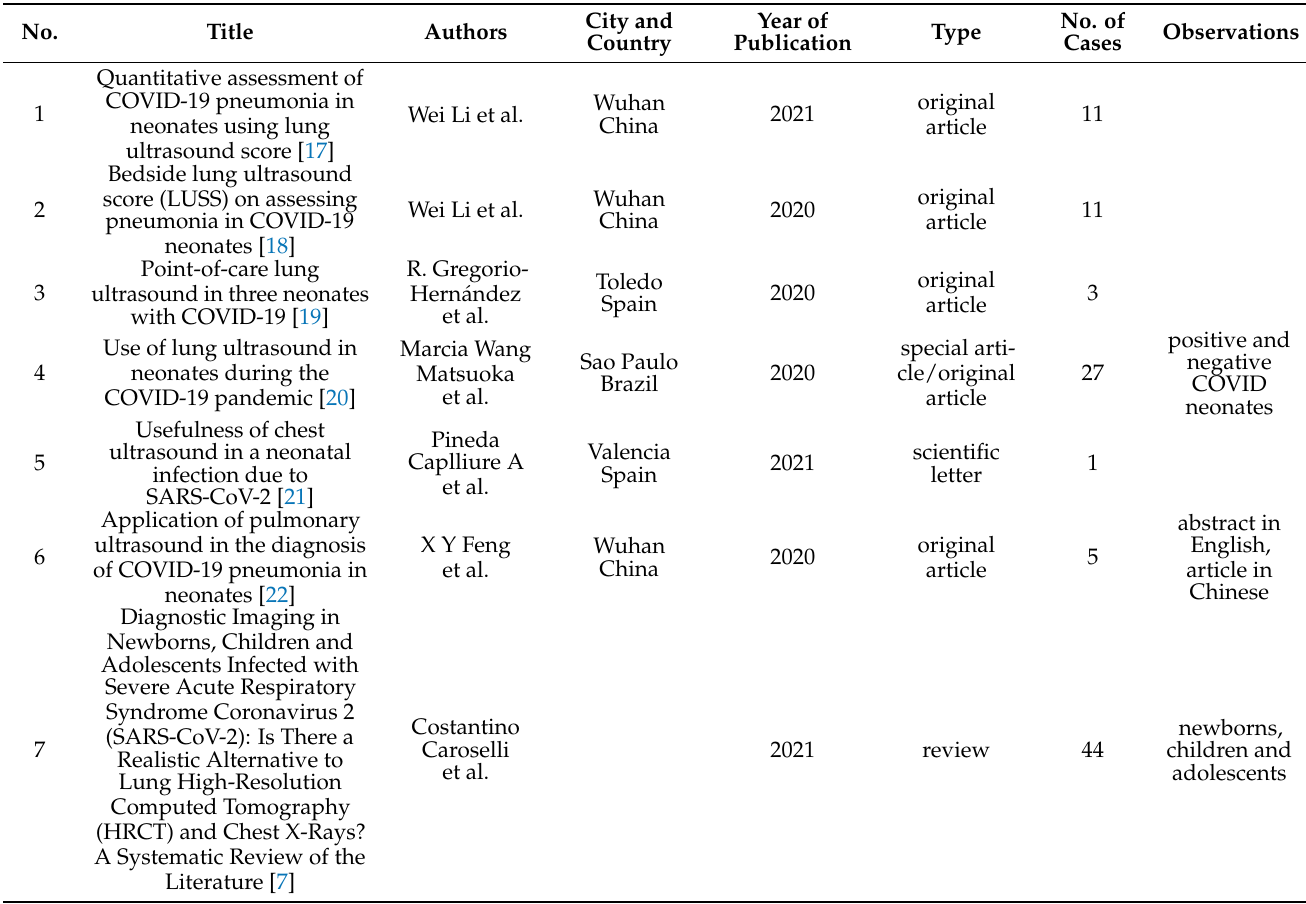
Table 1. Characteristics of the articles included in the